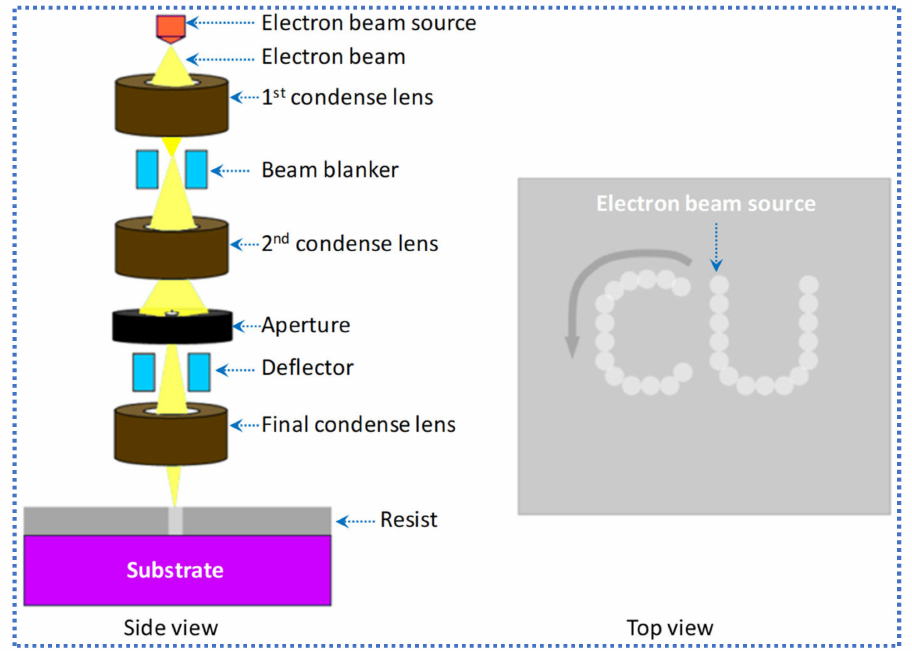
Figure 9. Schematic diagram of EBL